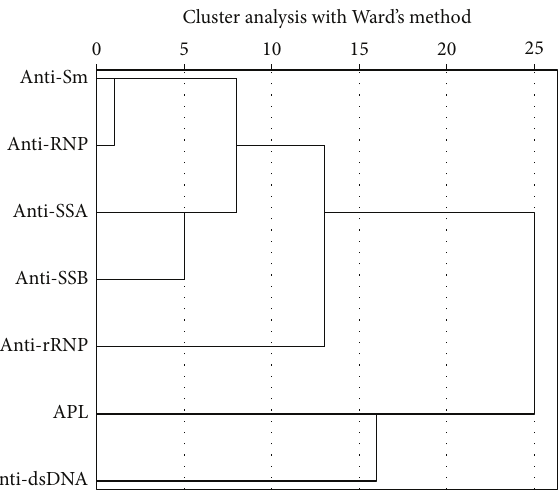
Figure 1: Result of cluster analysis with Ward’s method in SLE patients. Five clusters of antibodies were identified. Cluster 1 consisted of antibodies to Sm and RNP and cluster 2 consisted of antibodies to SSA and SSB. Clusters 3, 4, and 5 consisted of antibodies to ribosomal P, dsDNA, and APL,